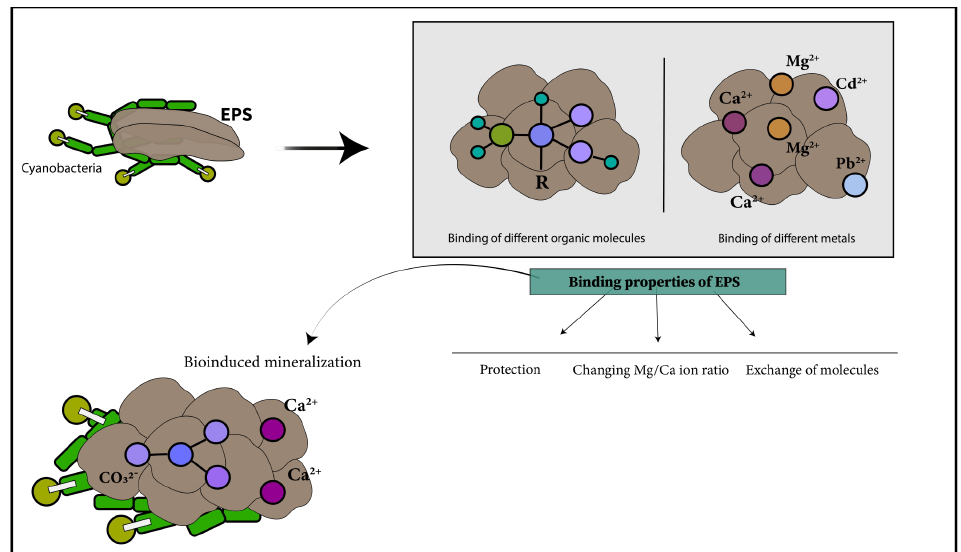
Figure 2. Schematic representation of EPS properties that contribute to the formation of biogenic carbonates. Binding properties of EPS are related to biological functions, such as protection for the producer microorganisms, ability to change the Mg/Ca ion ratio of the surrounding environment and the capacity to exchange molecules between the pericellular space and the microorganisms as well as between the microorganisms embedded in the EPS matrix. Its binding properties directly influence the carbonate mineral precipitation by the concentration of the metal ions and reactive molecules involved in the nucleation process [75–79].